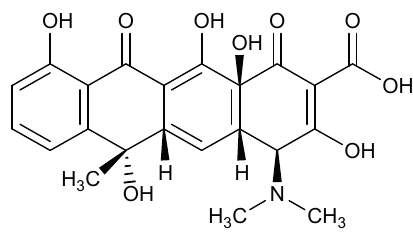
Figure 31. Molecular structure of doxycycline.